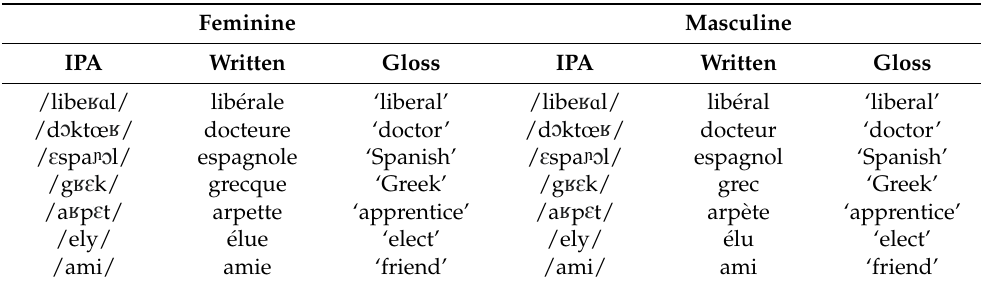
Table 2. Masculine and Feminine Homophones.